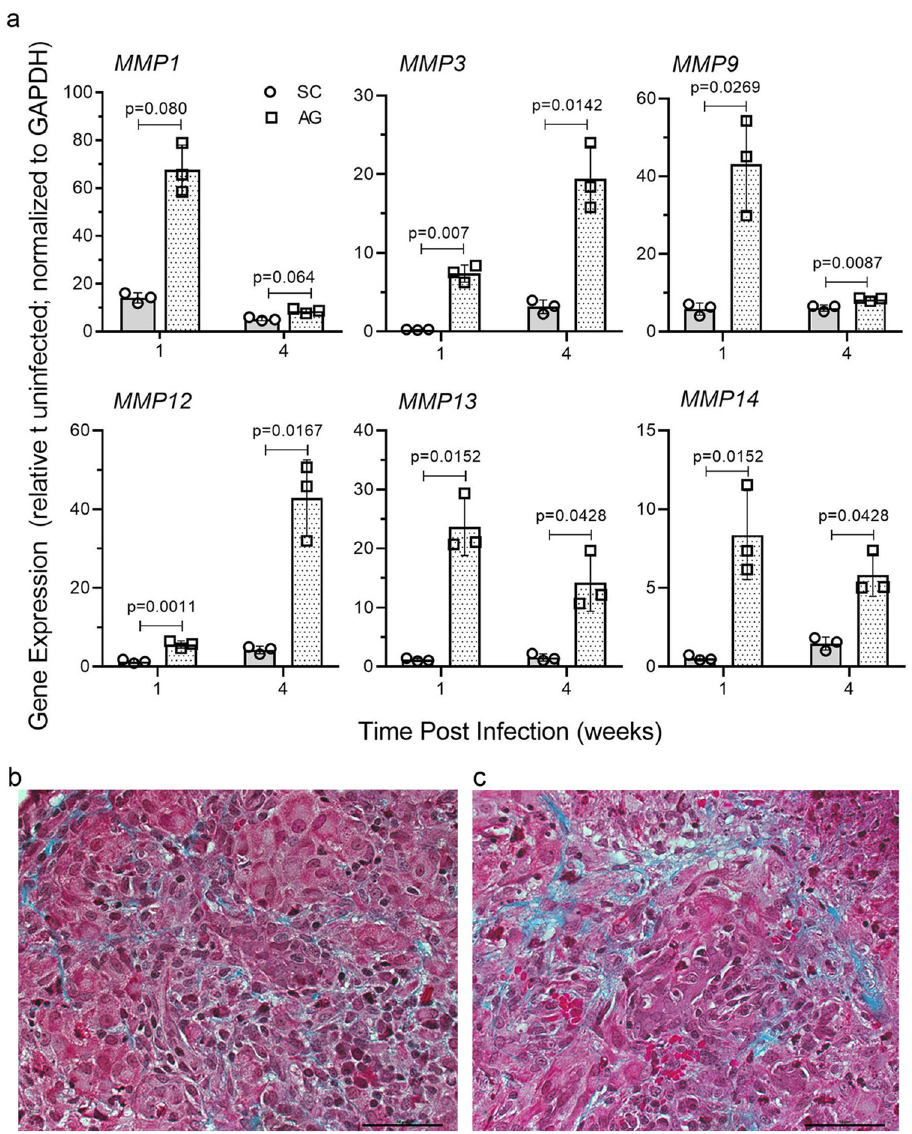
Fig. 7 Mtb-AG upregulates MMP gene expression and induces more fi brosis in infected rabbit lungs. a Expression level of MMP family genes was determined by qPCR using RNA from rabbit lungs infected with Mtb-AG or Mtb-SC at 1 and 4 weeks post infection. Expression levels of each target gene were normalized to GAPDH levels. Levels in uninfected animals were used to calibrate the values in Mtb-SC or Mtb-AG-infected groups. The experiment was repeated with three biological replicates in duplicates. Values plotted are mean ± standard error. Data were analyzed by Mann – Whitney U Test. * p < 0.05, ** p < 0.01. b Representative trichrome stained lung section of rabbits infected with Mtb-SC. c Representative trichrome stained lung section of rabbits infected with Mtb-AG showing the extent of collagen deposition and fi brosis (blue color) at 4 weeks. Original magni fi cation: ×400 ( b , c ). Scale bar in b and c is 50